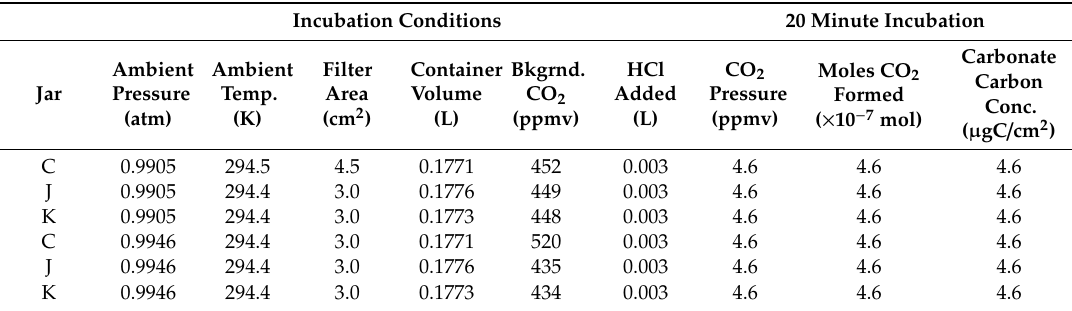
Table 2. Experiments performed aerosol particulate matter samples (PM > 2.5 ) to assess reproducibility on real samples.